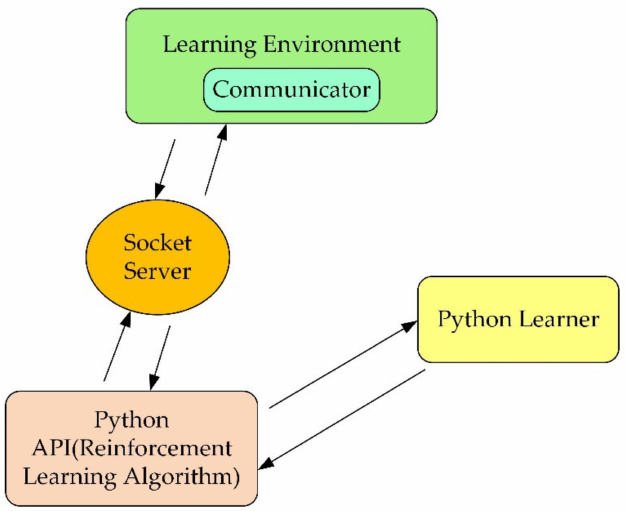
Figure 4. The relationship and structure diagram of the three major components of ML agents.